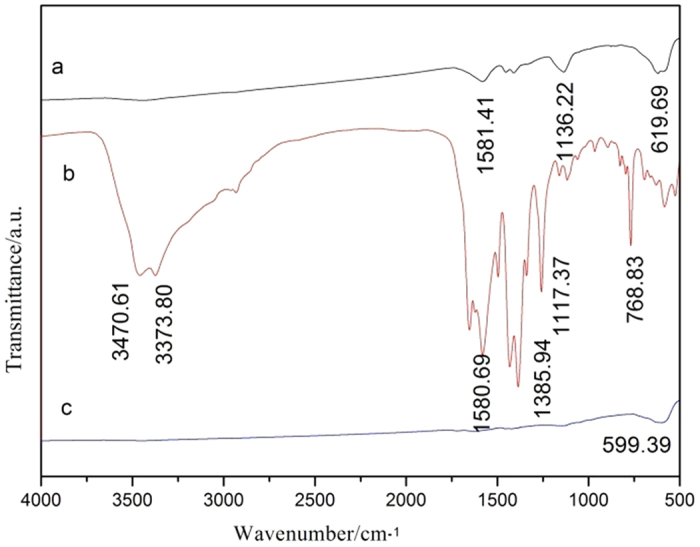
FTIR spectra of prepared (a) Fe3O4, (b) NH2-MIL-101(Fe) and (c) Fe3O4@NH2-MIL-101(Fe).